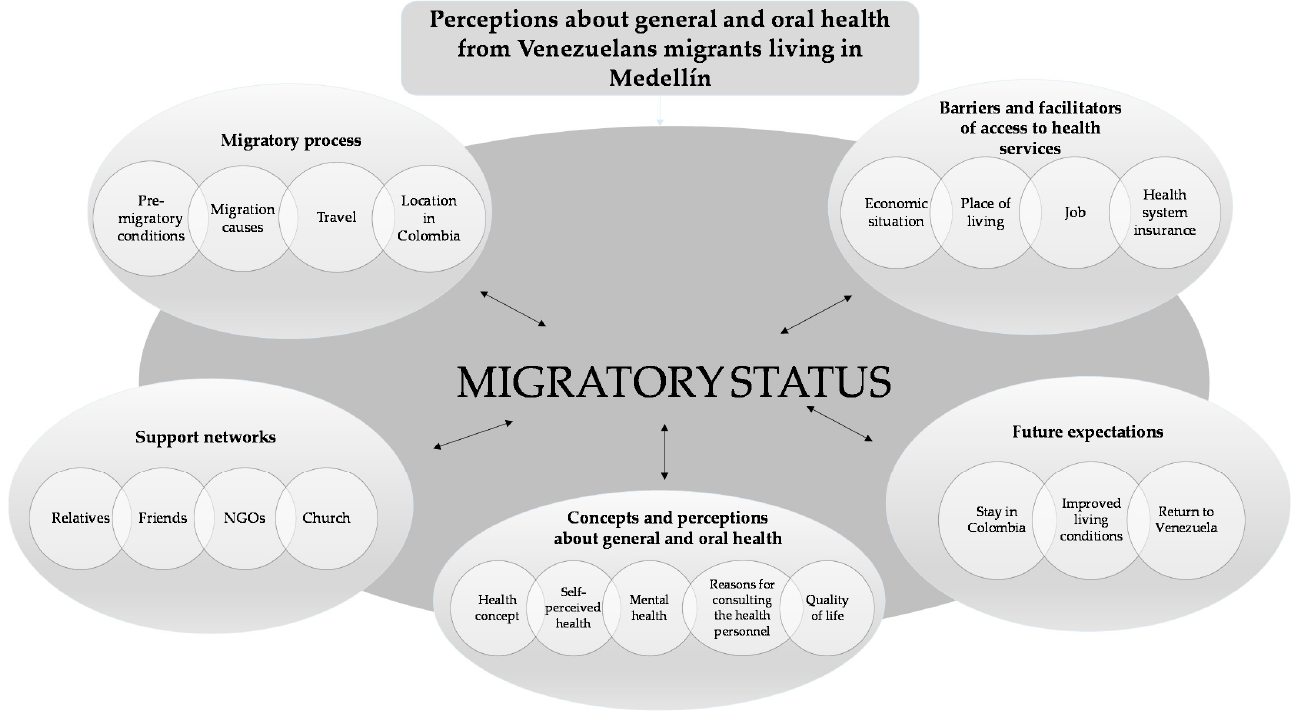
Figure 2. Final design for the categories based on the qualitative findings. NGOs: nongovernmental organizations.